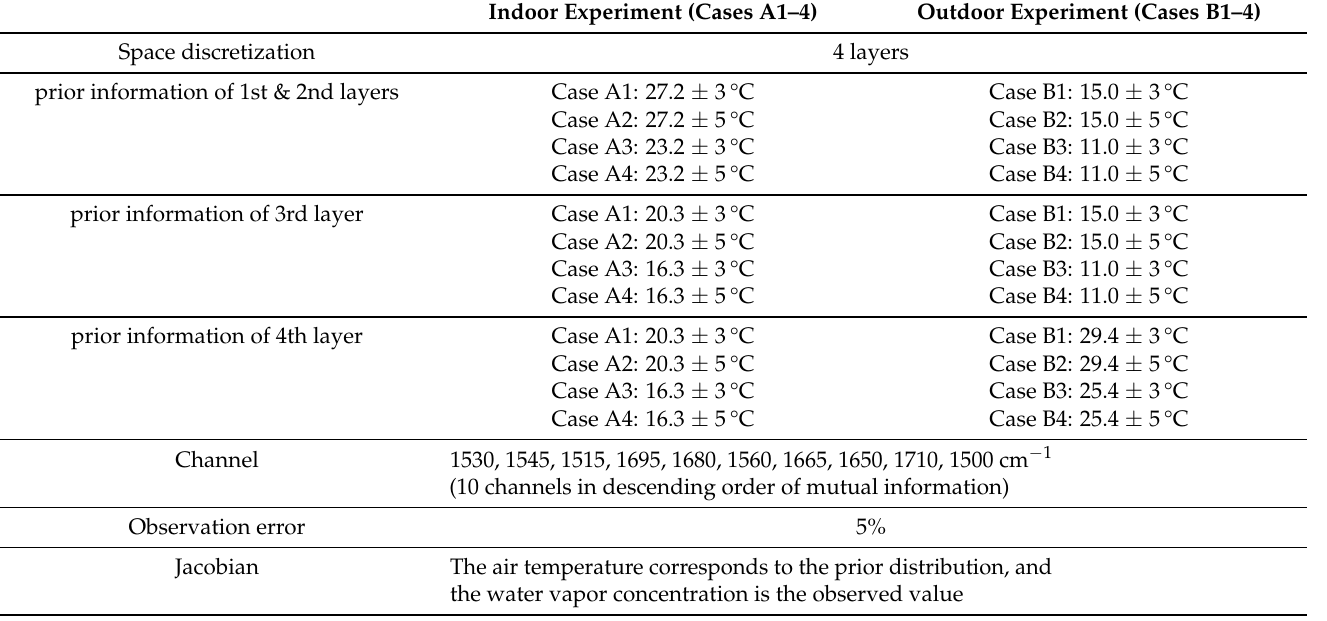
Table 2. Conditions related to the MAP method. For the case studies, the mean air temperature of the prior distribution x a in both the indoor and outdoor experiments was set to 2°C higher (cases A1, A2, B1, and B2) and 2°C lower (cases A3, A4, B3, and B4) than the actual value measured by the thermohygrometer. In addition, the uncertainty of the prior information was calculated in two cases: when the standard deviation of the prior information of air temperature (i.e., square root of the diagonal component of S a ) was 3°C (cases A1, A3, B1, and B3) and when it was 5°C (cases A2, A4, B2, and B4). In the indoor experiment, the air temperature in the heating room was 25.2°C and that in the non-heating room was 18.3°C. In the outdoor experiment, the outdoor air temperature was 13.0°C, and the heating room air temperature was 27.4°C. Indoor Experiment (Cases